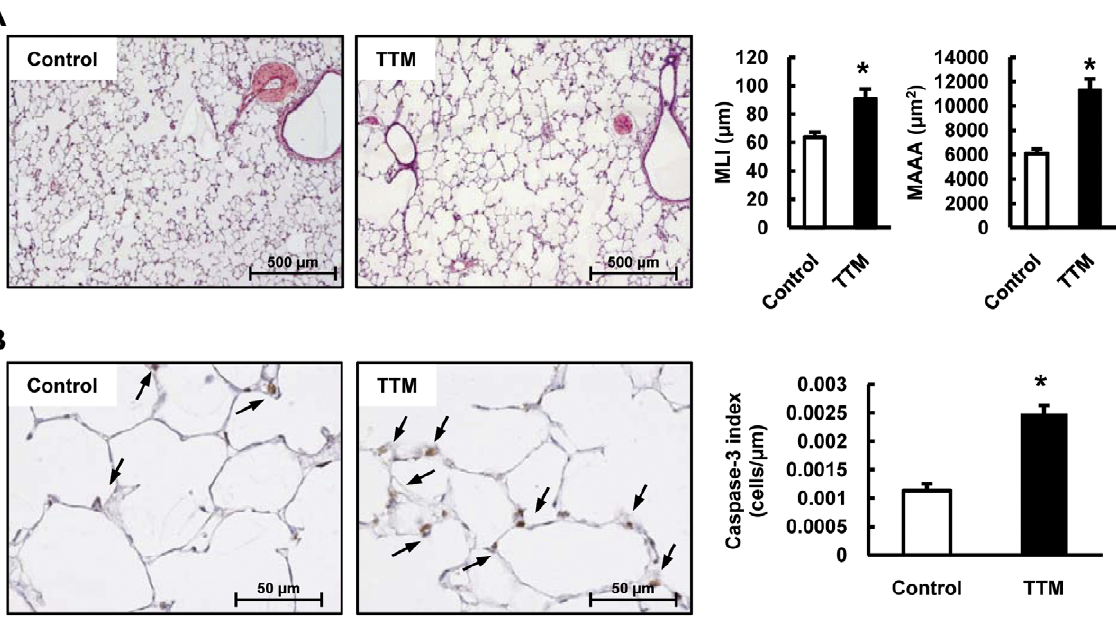
Figure 1. Copper depletion by a copper chelator (tetrathiomolybdate:TTM) treatment causes emphysema and lung cell apoptosis. (A) Representative photomicrographs of HE-stained lung sections of control and TTM treated rats. The bar graph shows the quantification of mean linear intercepts (MLI) and the mean alveolar airspace area (MAAA) in lung sections from Control and TTM treated rats. Data are expressed as mean 6 SE (n=6). *P , 0.05 versus control. (B) The photomicrographs of the lung immunohistochemical staining for cleaved caspase-3 are represents of Control and TTM treated rats. The bar graph shows the Caspase-3 positivity index of lung sections from control and TTM treated rats. The Caspase-3 positivity index was calculated as described in the Materials and Methods section. Data are expressed as mean 6 SE (n=6). *P , 0.05 versus control.